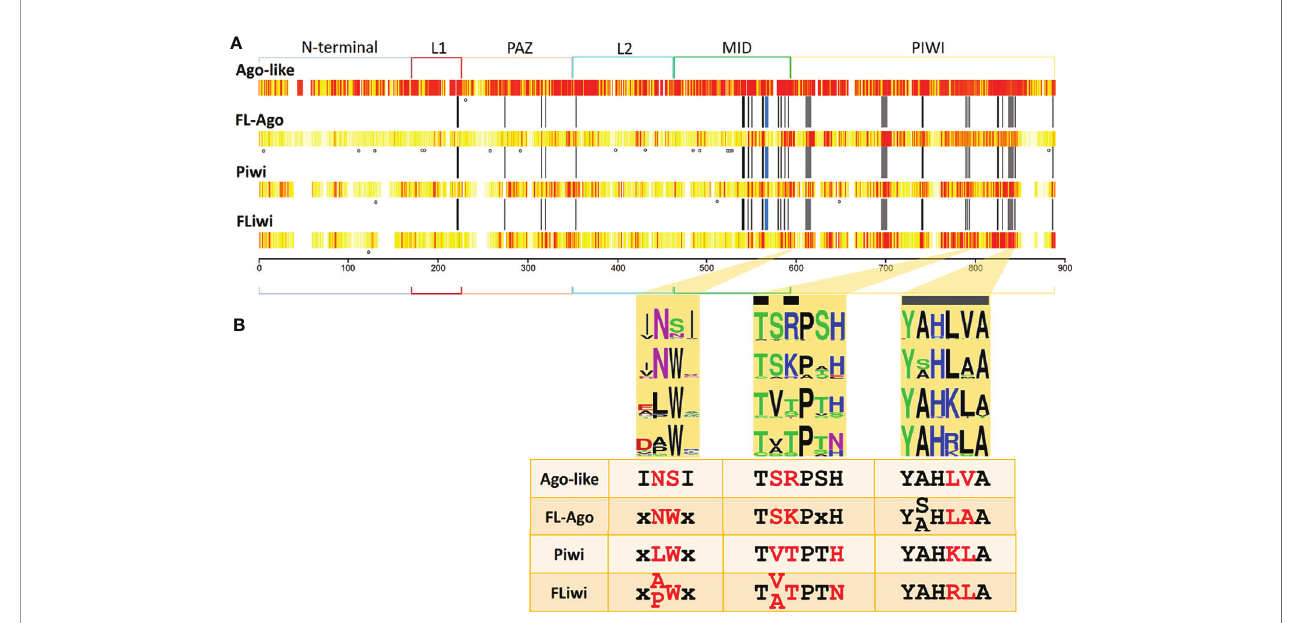
FIGURE 5 | Sequence conservation among Argonaute subfamilies. (A) Conservation is shown in a white (less conserved) to red (most conserved) color scale. N-terminal, linker 1 (L1), PAZ, linker 2 (L2), MID and PIWI domains are indicated. Black bars indicate the positions that have been reported to interact with the miRNA (Elkayam et al., 2012). Grey bars indicate the positions of the catalytic DDH triad. Blue bar indicate the position that has been reported to interact with the seed region of miRNAs (Maldonado et al., 2017). Dots indicate positions with statistically signi fi cant LRT (p-value ≤ 0.05) detected with MEME tool. (B) Highlight of three regions of the MID and PIWI domains that produce a signature for each Ago subfamily. Black bars indicate the positions that have been reported to interact with the miRNA. Grey bars indicate the positions of the catalytic DDH